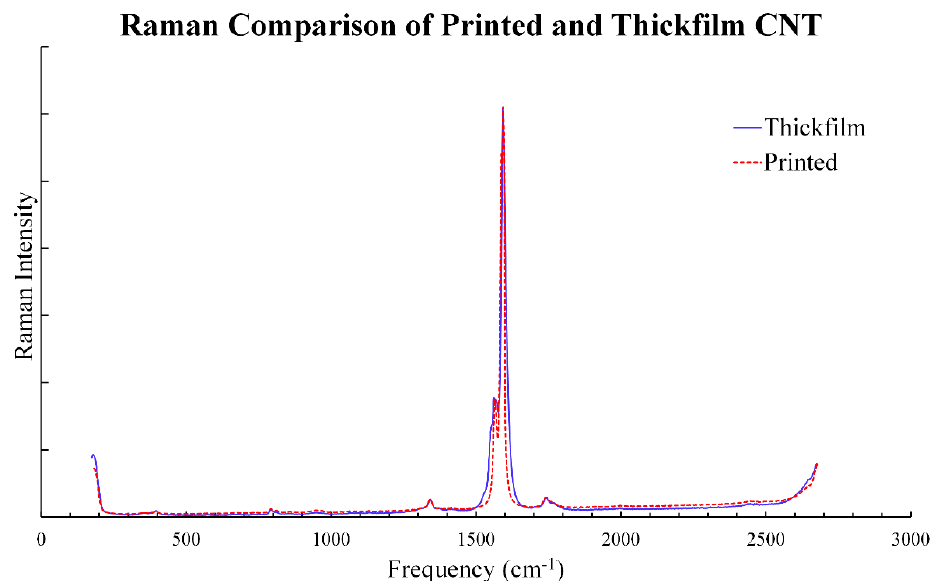
Figure 5. Raman spectroscopy of the thickfilm and printed film shows no significant shift in peaks, revealing very little contamination from un-annealed solvents.